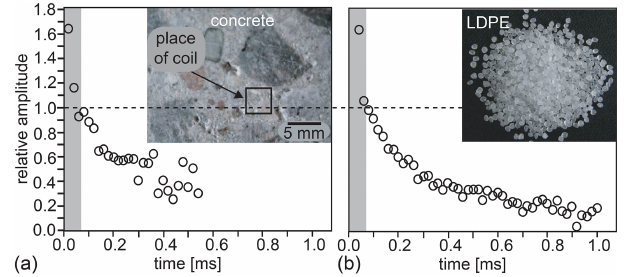
Figure 3. Transverse magnetization decays acquired with the Mini- MOUSE (Fig. 2j) at short echo time t E . The shaded area marks signal lost at a dead time of 70µs. (a) The signal from bound wa- ter in dry, gray cement. (b) The crystalline protons in low-density polyethylene with T 2 = 12µs can be detected at t E =